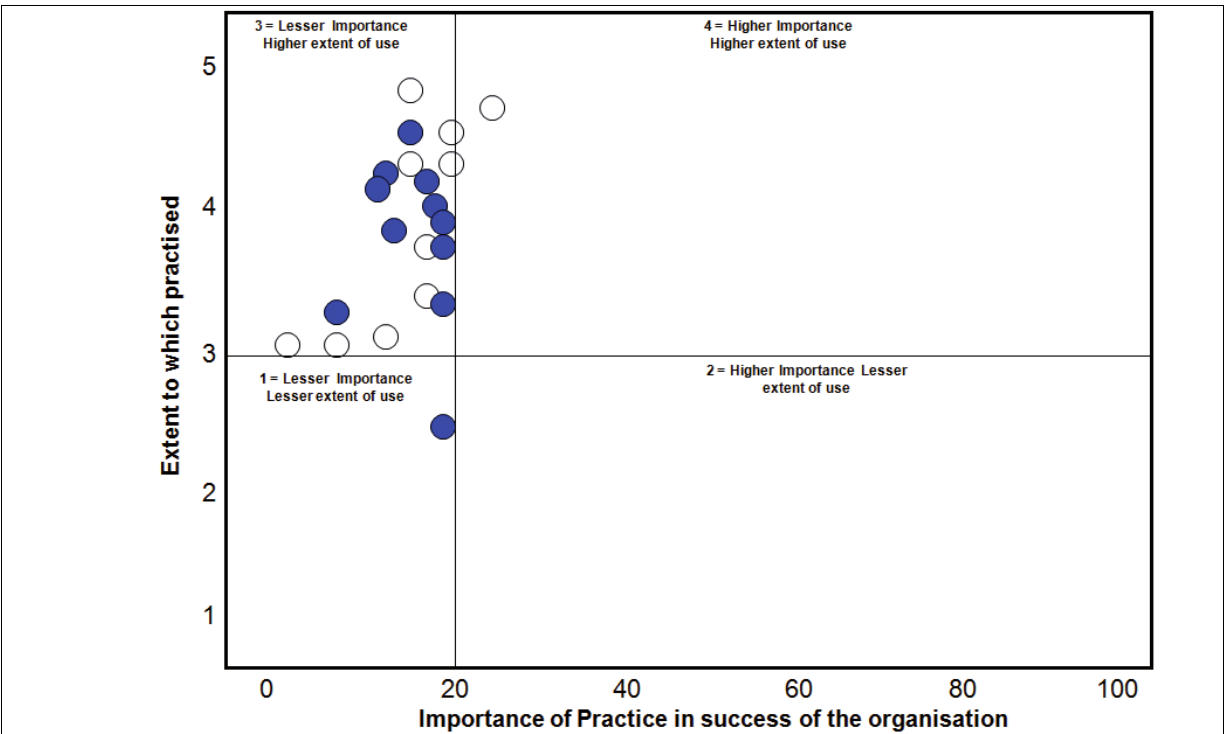
FIGURE 2 Scatter plot example for practice 3.5: Partnering with our stakeholders drives continuous improvement and innovation for everyone, as indicated in Table